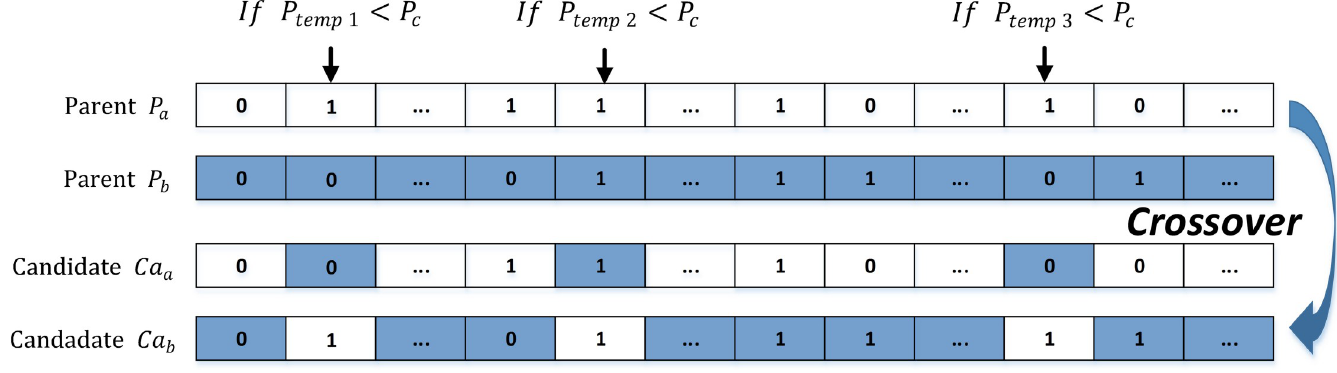
Fig 2. Uniform crossover based on selected parents.